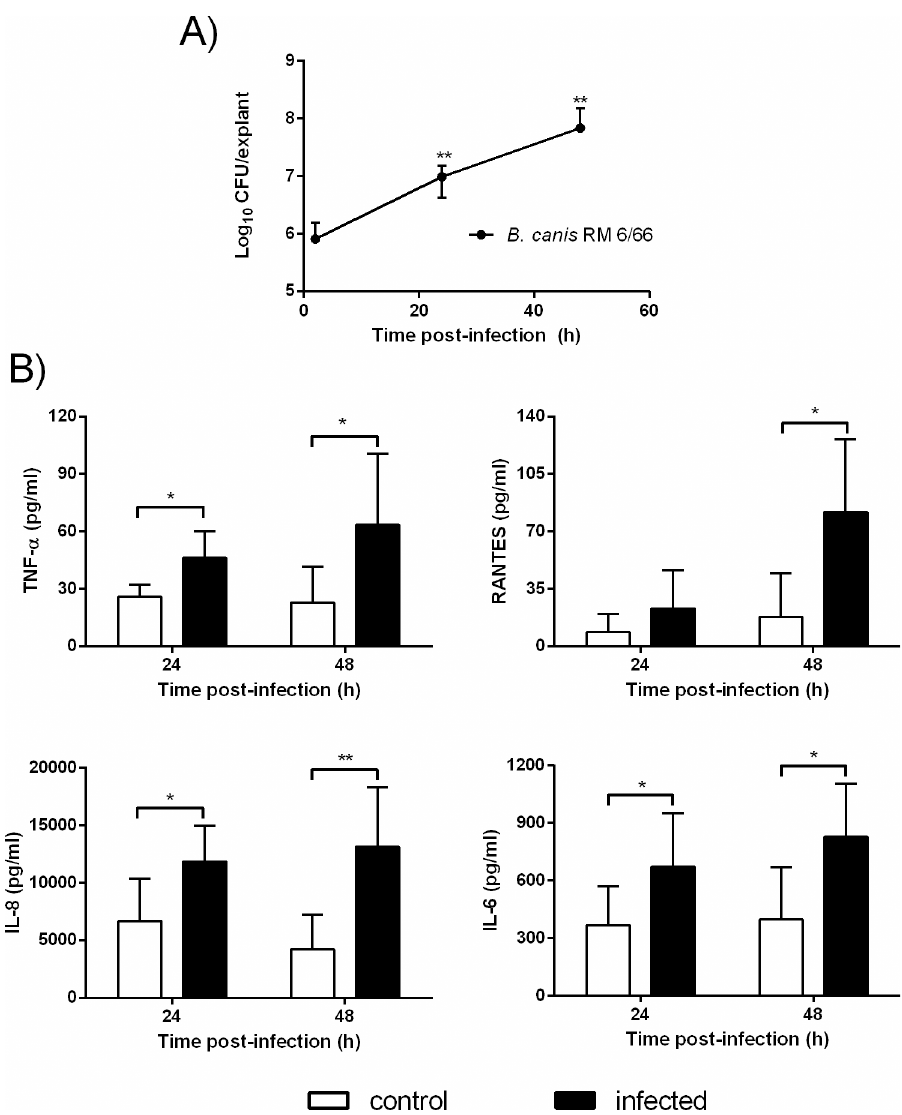
Fig 4. Intracellular bacterialreplication and cytokinesecretionin canine placental explantsinfected ex- vivo with B . canis . Explants wereobtainedfrom 3 term placentascollectedby C-section of healthydogs, and wereinfectedwith 1x10 8 CFU of B . canis for 2 h. The explantswerewashedwith PBS and extracellular bacteria werekilledby the additionof antibiotics.(A) Explants homogenates were obtainedat 2, 24 and 48 h p.i. and platedon TSA to count intracellular CFU. (B) Culturesupernatants were collectedat 24 and 48 h p.i. to measure TNF- α ,RANTES (CCL5),IL-8 and IL-6 secretion.Valuesare means ± SD of duplicatemeasurements from threeindependent experiments. In panelA, asterisks indicatesignificant differencesas comparedto 2 h. p.i. ( ** p < 0.01,Mann-Whitney test). In panelB, asterisks indicatesignificantdifferencesas comparedto uninfected (control) cells ( * p < 0.05; ** p < 0.01,Student ᾽ s t test).